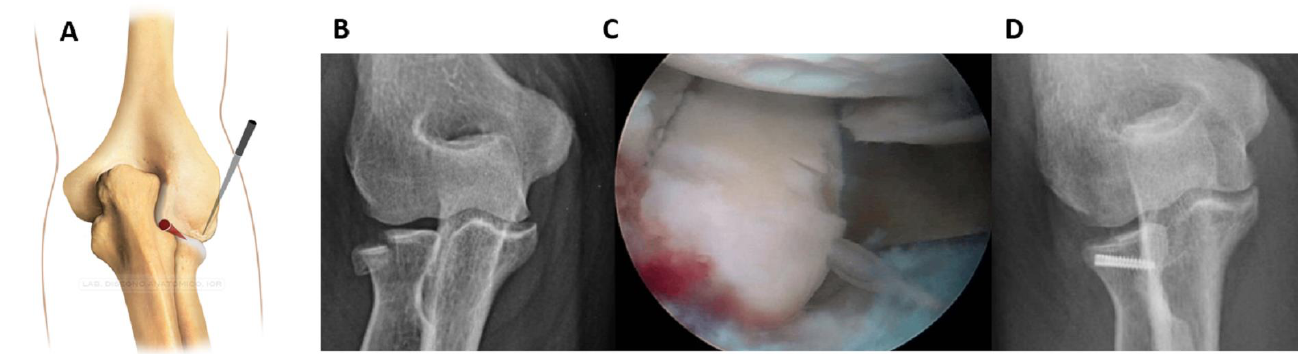
Figure 2. Fracture of lateral half of radial head that is fixed using the posterolateral working posi- tion; posterolateral and midlateral portals were created ( A ). From the superior view, the shaver and probe created the necessary space to reduce the fragment. ( B ): Pre-operative x-ray showing the frac- ture. ( C ): Intraoperative image of fracture fixation. ( D ): Control x-ray. Posterolateral and midlateral portals were created. From the superior view, the